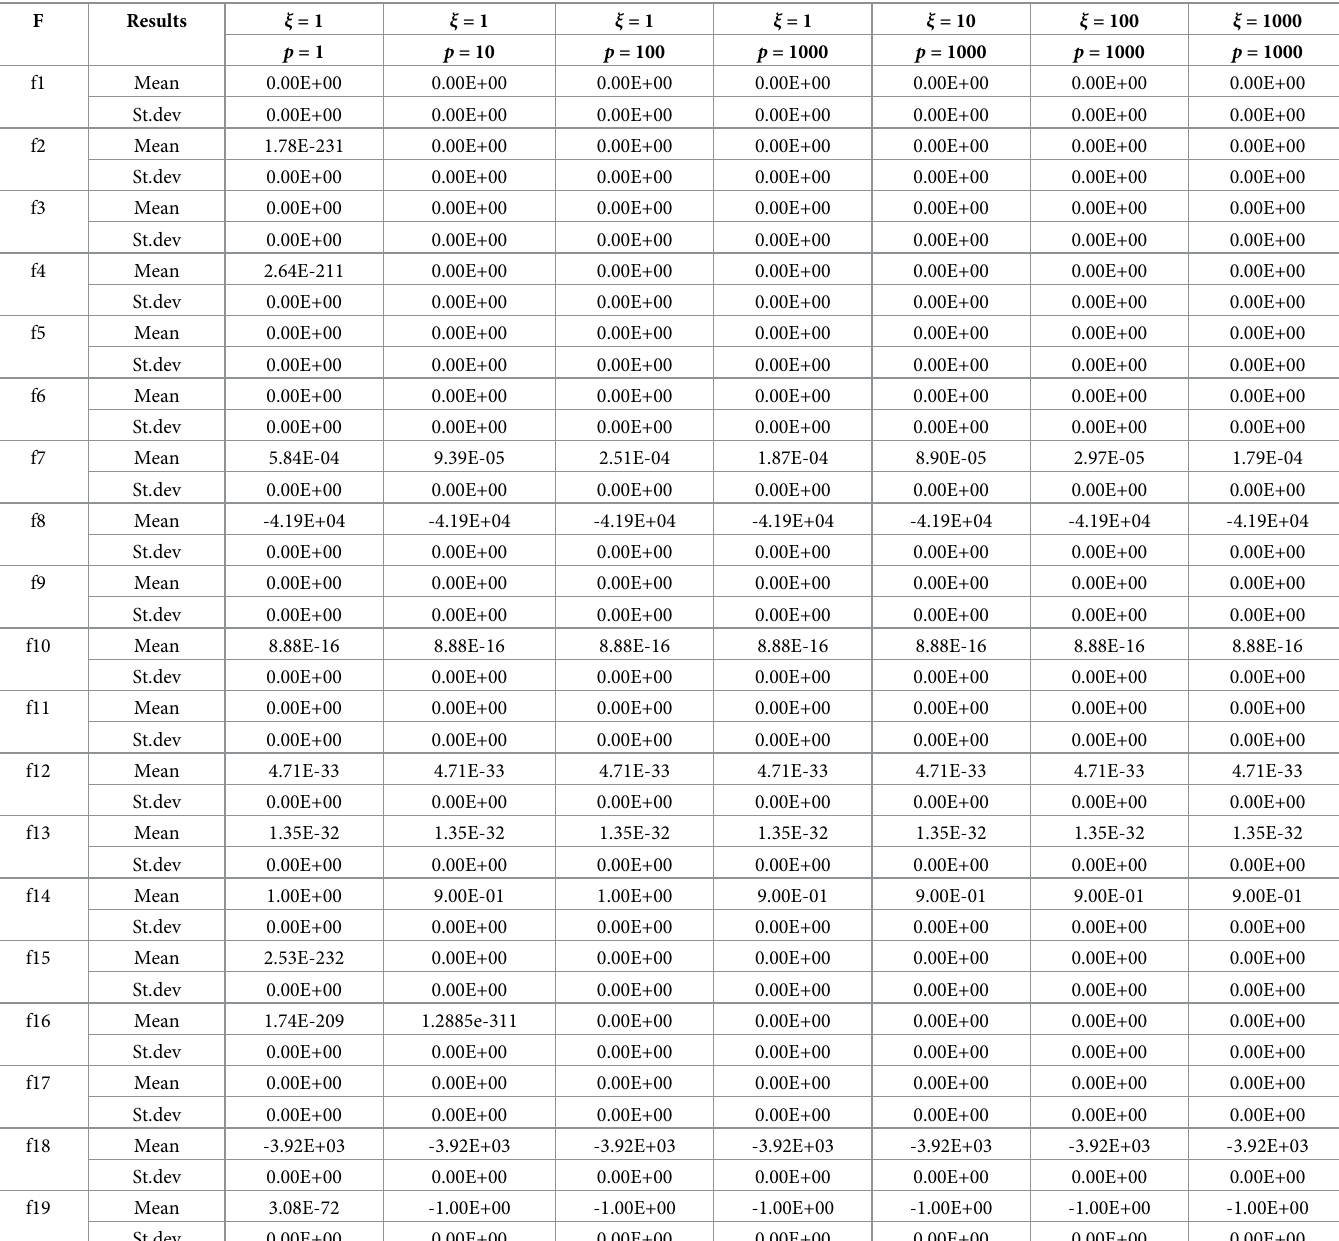
Table 11. Experimental results of CRLPO for 19 test functions with typical combinations of ξ and p (Dim =